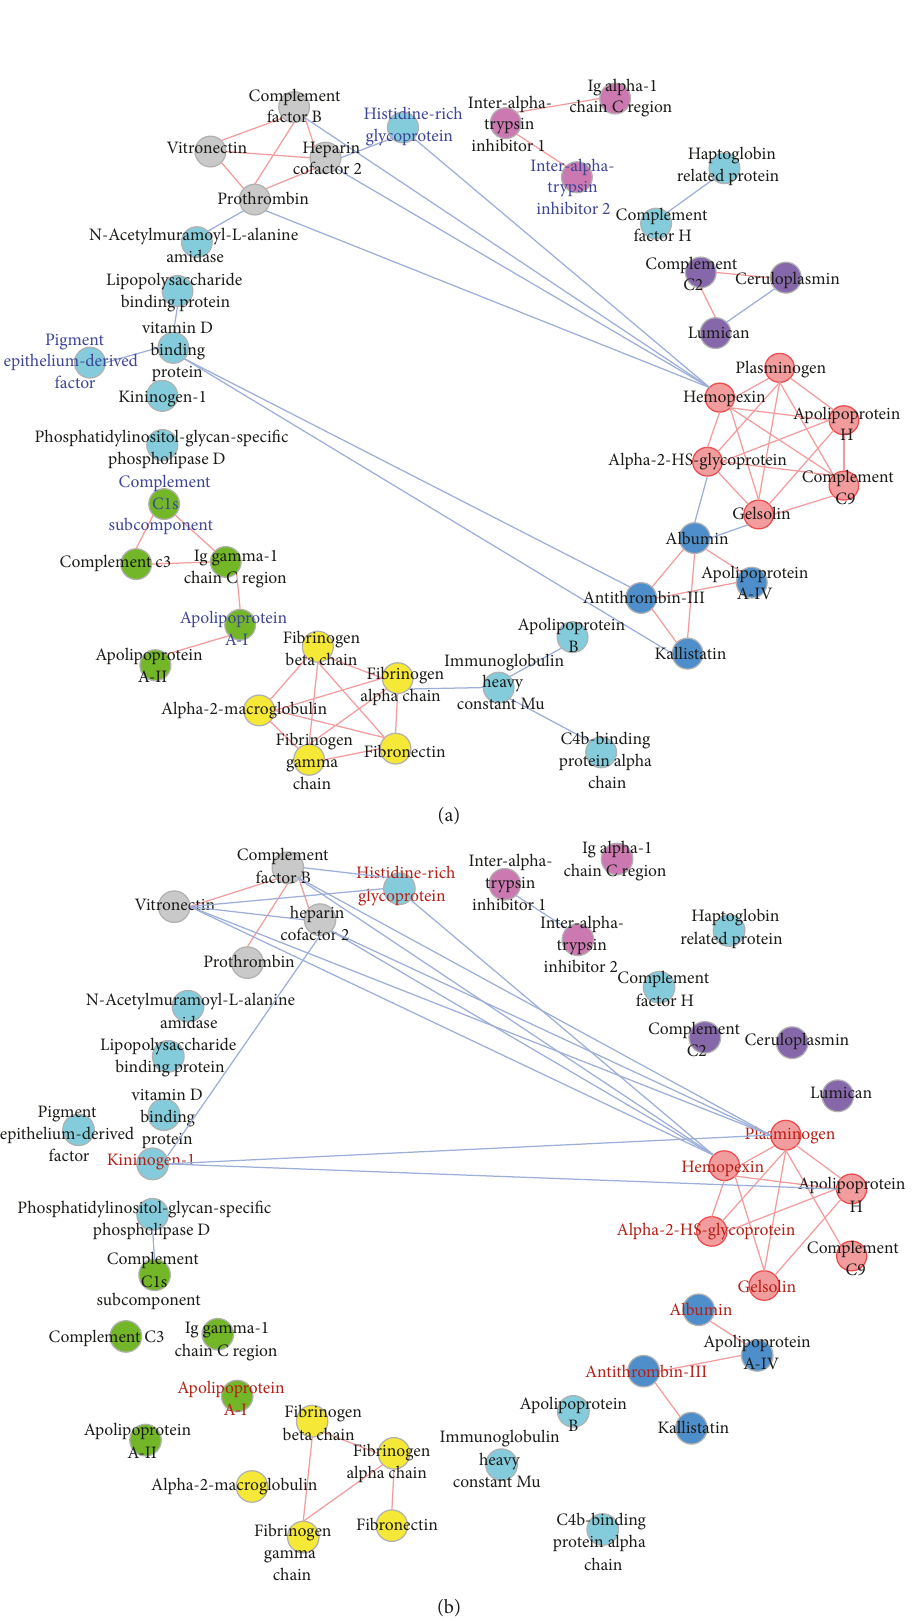
Figure4: HDL-associatedPPInetworksforthe(a)leangroupand(b)T2Dgroup .Nodesrepresenttheproteinsandedgesrepresentcomigration relationship. Intracluster edges are marked as dark pink, and intercluster edges are blue. Significantly PWV-correlated proteins are denoted with red text (positive) and blue text (negative). Clustered protein groups are marked with different